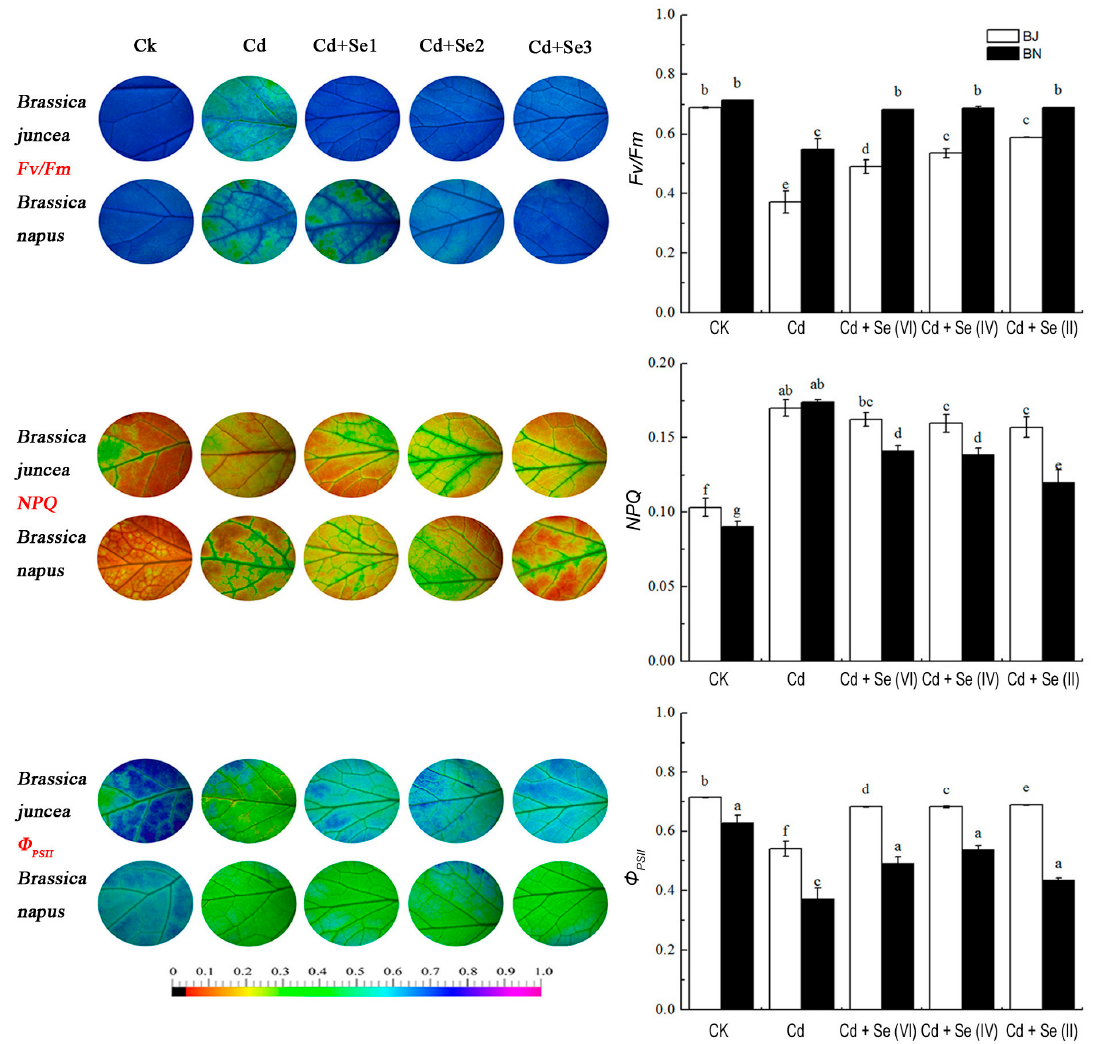
Figure 5. ChlorophyII fluorescence parameters maximum photochemical quantum yield of photosystem II (PSII) (F v / F m ), actual photochemical efficiency ( Φ PSII ), and non-photochemical quenching (NPQ) of Brassica juncea (BJ) and Brassica napus (BN) under different treatments. Representative fluorescence images of different treatments are shown on the left panel. Quantitative values are shown on the right panel. F v / F m , the maximum efficiency of PSII photochemistry in the dark-adapted state; Φ PSII , the quantum yield of PSII electron transport; NPQ, the non-photochemical quenching coefficient. All values were means ± SD ( n = 3). Different small letters indicate significant difference at P < 0.05. Table 1. Photosynthesis of two Brassica species under the different treatments. Values are mean ± SD ( n = 3). Different small letters indicate significant difference at P < 0.05.